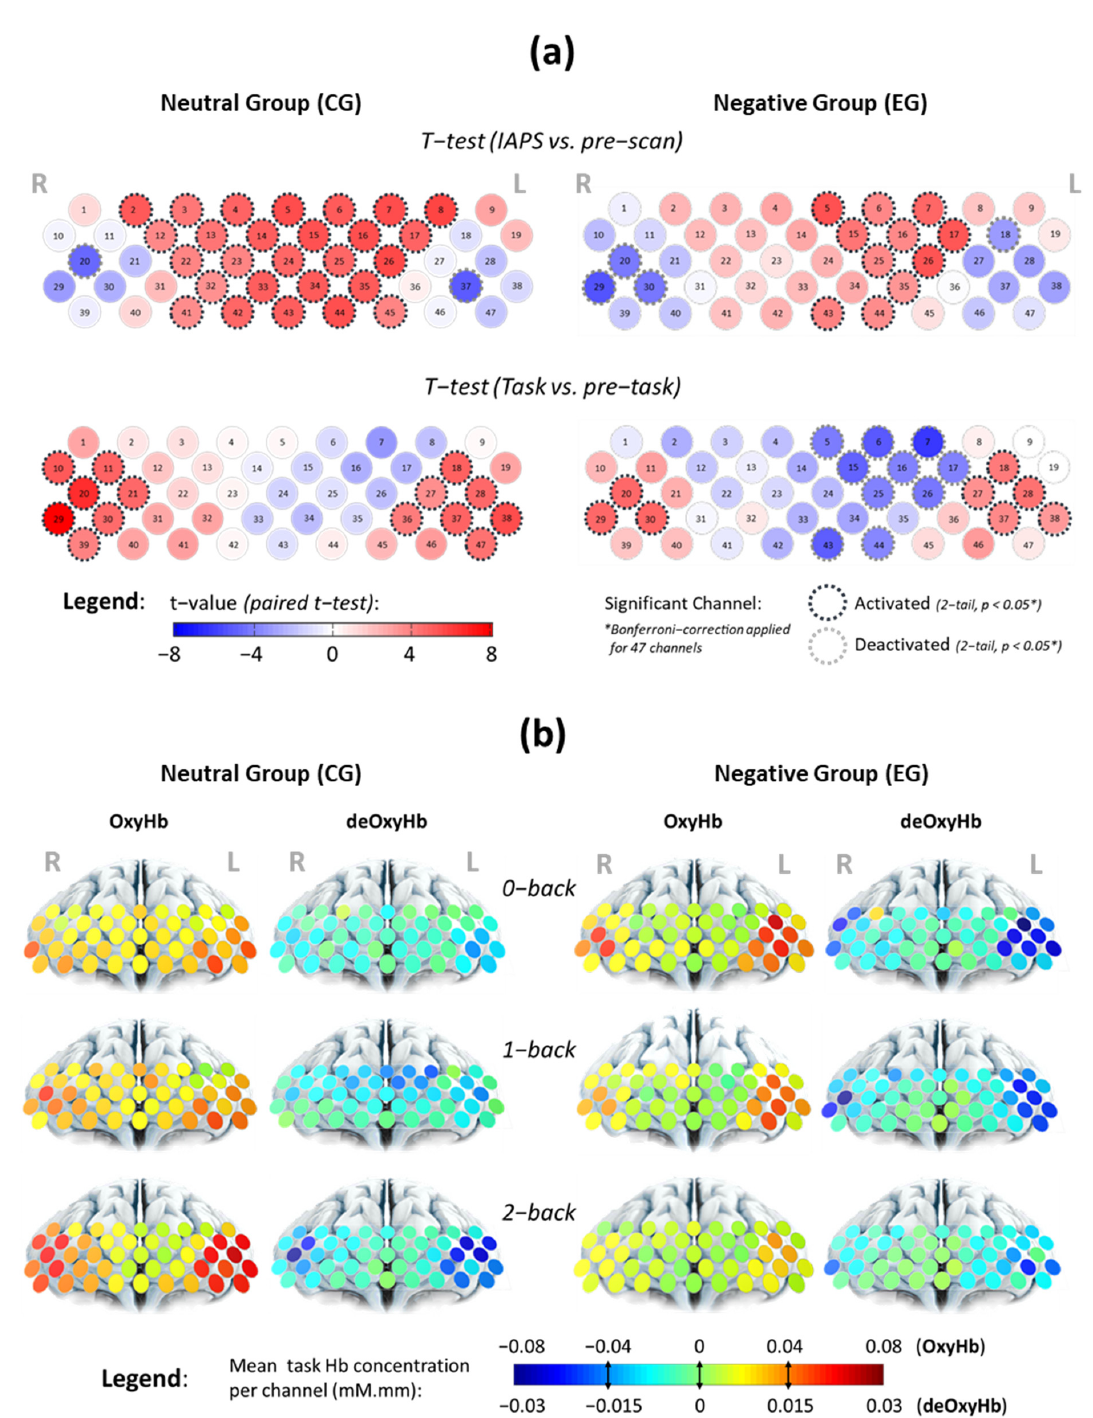
Figure 2. Analysis of channel-wise contrast using ( a ) a paired t -test under merged WML conditions to determine if the mean OxyHb changes towards IAPS images and WM tasks are region-specific and how ( b ) mean OxyHb and deOxyHb changes with affective states and WMLs during n-back tasks. Intensifying red in ( a ) indicates a stronger positive contrast of signal amplitude, while intensifying blue indicates negative changes. Pale colour indicates comparable signal level between both periods. Significant activated and deactivated channels were circled with black and grey dotted lines, respectively, after Bonferroni–Holm’s corrections. Warmer colours in ( b ) indicate higher activation for OxyHb during WM tasks, while colder colours indicate greater reduction in